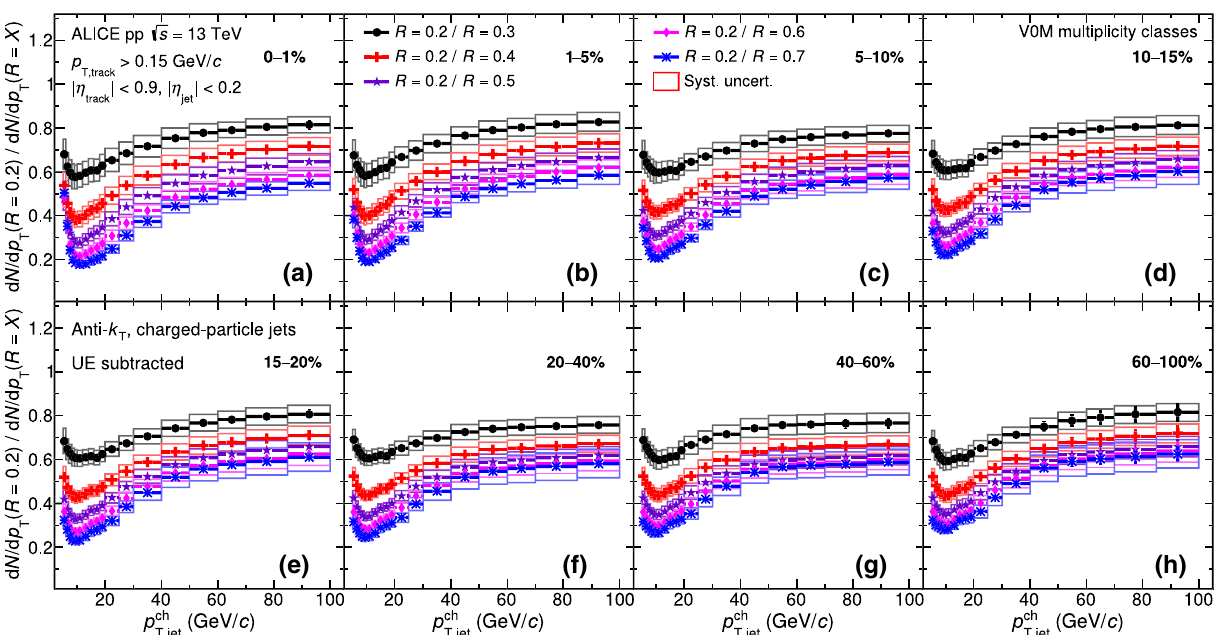
Fig. 9 Ratios of charged-particle jet spectra with R = 0 . 2 to that with other jet resolution parameters R from 0 . 3 to 0 . 7, shown in different V0M multiplicity classes. Statistical and systematic uncertainties are shown as vertical error bars and boxes around the data points, respectively